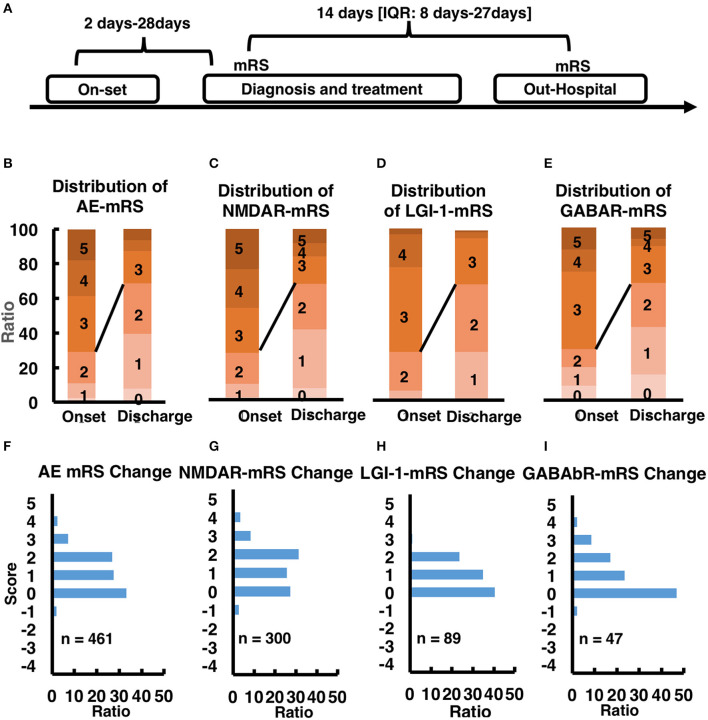
(A) time line of mRS-taking. (B–E) mRS score at onset stage and out-hospital stage in AE patients and other subtype AE patients. (F–I) mRS score change after treatment in AE patients and other subtype AE patients.